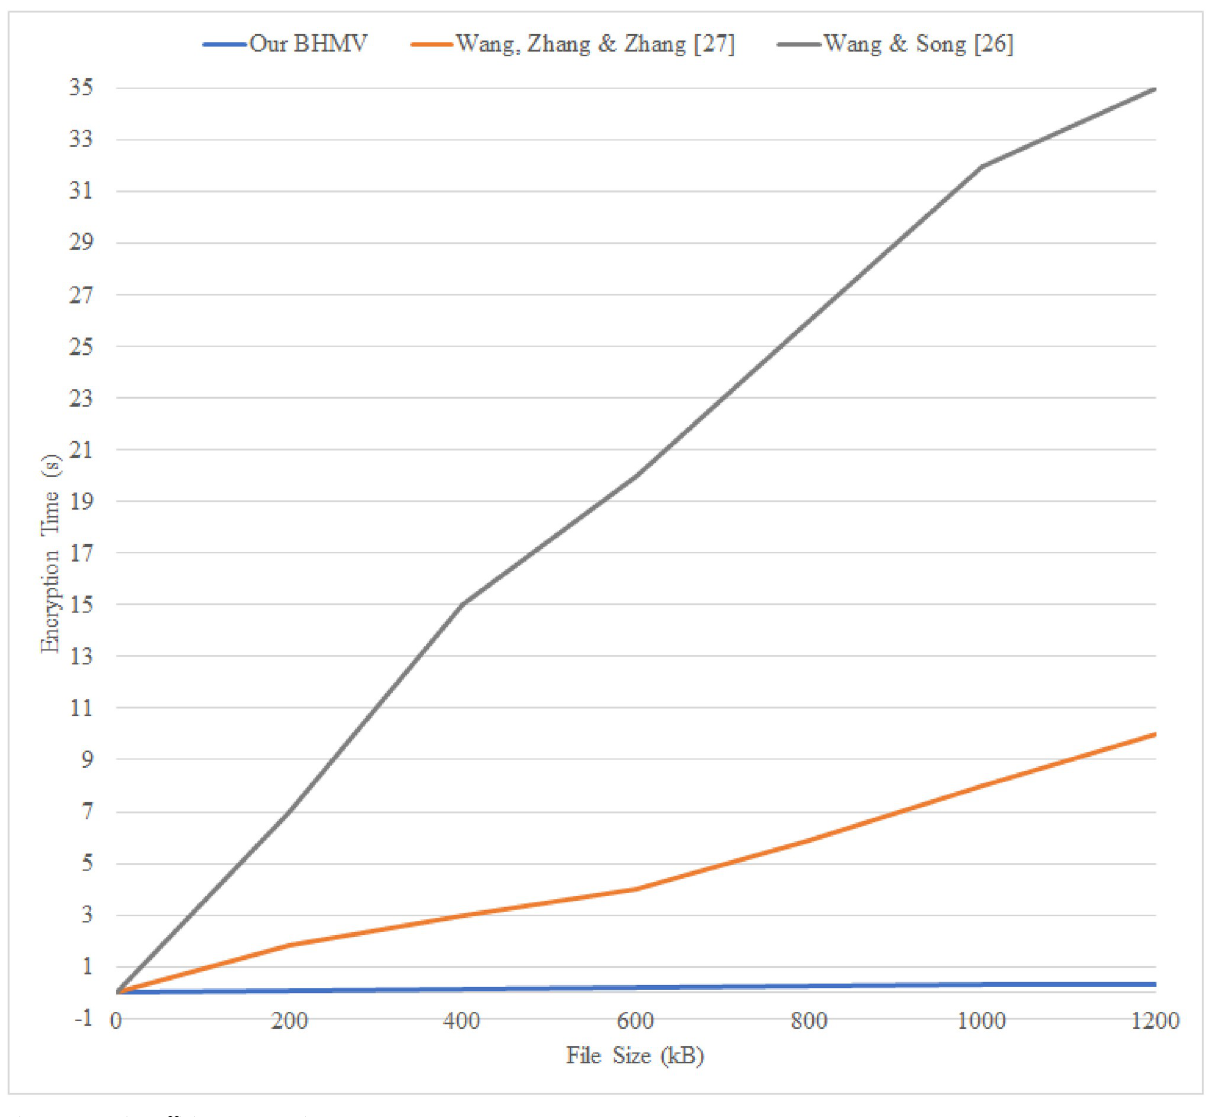
Fig 6. Encryption efficiency